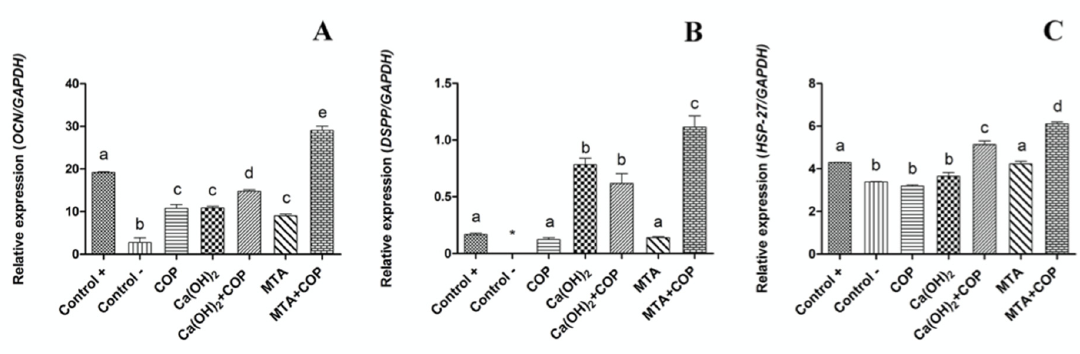
Figure 4. Graphic representation of the relative expression of the OCN ( A ), DSPP ( B ), and HSP-27 ( C ) genes in all the experimental groups. Different letters indicate significant differences among the groups for the same gene ( p < 0.05). Bars indicate the standard error of the mean.